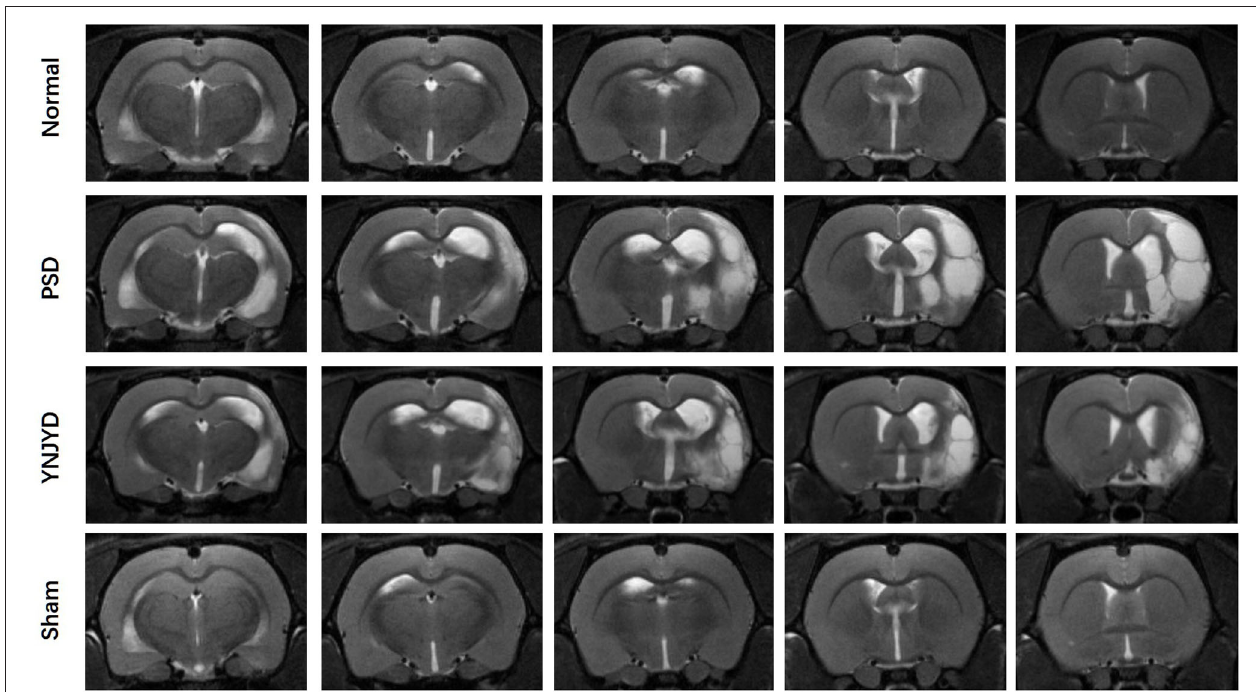
FIGURE 4 | T2-weighted magnetic resonance imaging of normal, post-stroke depression (PSD), YNJYD-treated, and sham-operated rats.